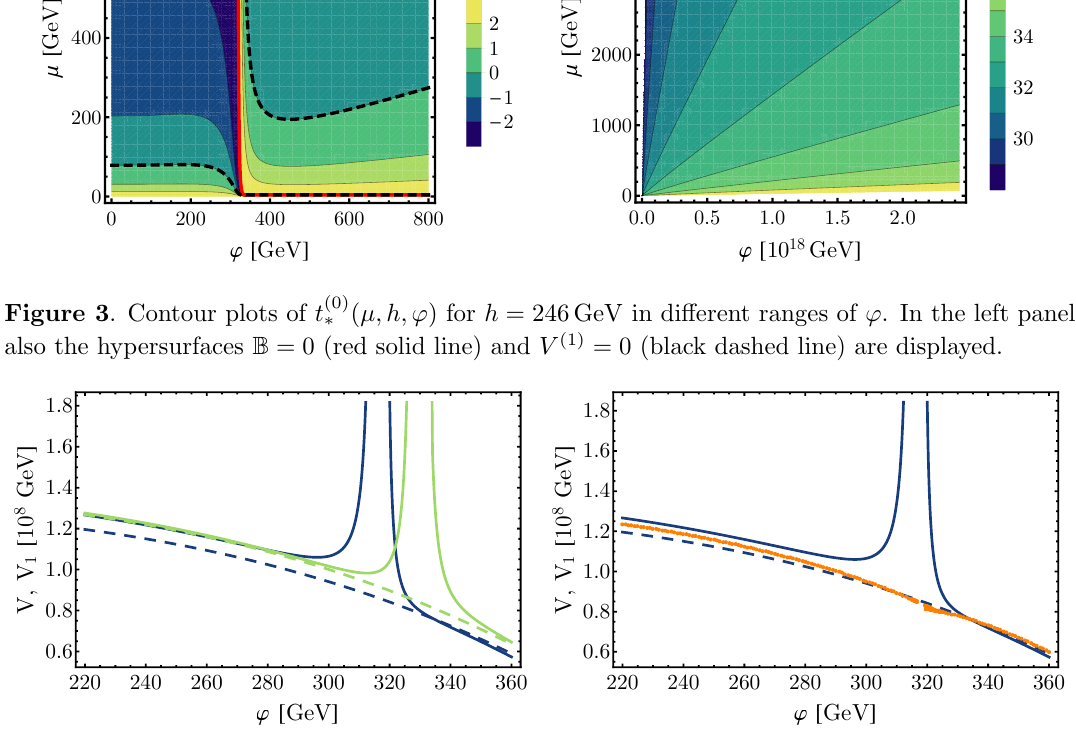
Figure 4 . Left panel: the one-loop unimproved e(cid:11)ective potential V 1 (dashed lines) and the one-loop improved e(cid:11)ective potential V (solid lines) for two values of renormalisation scale (cid:22) , (cid:22) = 246 GeV (green) and (cid:22) = 800 GeV (dark blue). The value of h is (cid:12)xed to 246 GeV at the scale (cid:22) = 800 GeV (the value at (cid:22) = 246 GeV is obtained as a value of the running (cid:12)eld at this scale). Right panel: the one-loop improved (with t (0) (cid:3) approximation) and unimproved potential for (cid:22) = 800 GeV showed in the left panel (dark blue) superimposed with the one-loop improved potential (with full t (cid:3) )